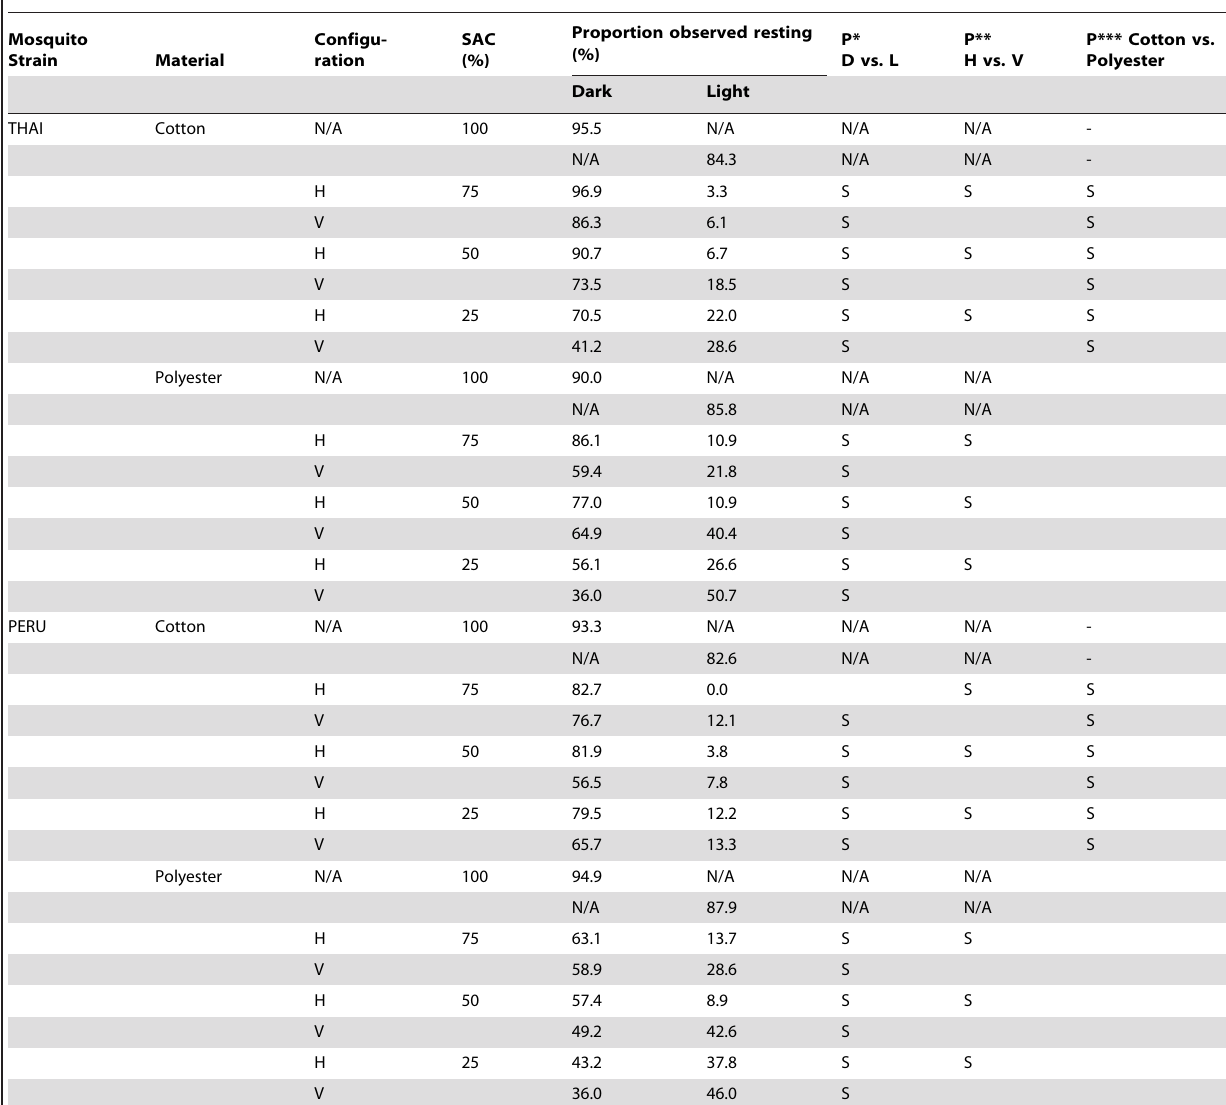
*Chi-square comparison for resting on the dark versus light material at each D:L SAC. **Chi-square comparison for resting on the dark versus light when dark material strips are on vertical versus horizontal configuration at each D:L SAC. ***Chi-square comparison for resting on the dark versus light when cotton was used versus polyester at each D:L SAC. S = P , 0.05; NS = P . 0.05; N/A = Not applicable; - = Not performed; D = dark; L = light; SAC = surface area coverage; H = horizontal; V = vertical; N = 60 from a total of 6 replicates performed for each assay type. 82.7% and 95.2% vs. 87.9% dark vs. light with cotton and polyester, respectively) strains ( P , 0.05). Results for both Ae. aegypti strains show significantly higher resting observations on dark cotton and polyester strips over light ( P , 0.05) at each D:L SAC ratio and contrast configuration design (horizontal and vertical) (Table 1). Effects of configuration (vertical versus horizontal) on resting patterns. For both THAI and PERU Ae. aegypti strains, resting observations on dark material (both cotton and polyester) was significantly increased when placed in a horizontal versus vertical configuration design. This was true at all three D:L coverage ratios ( P , 0.05) (Table 1).